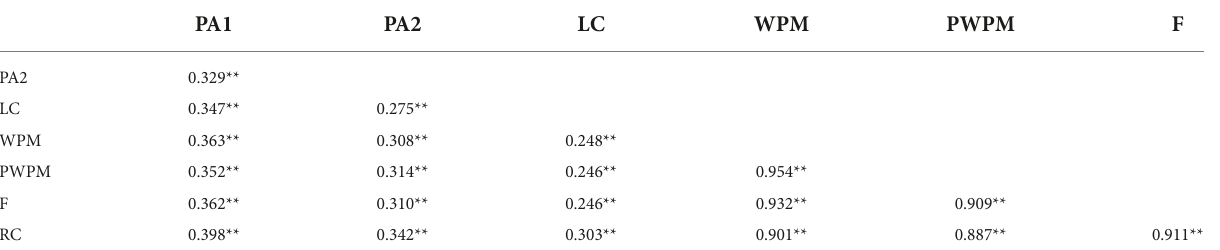
TABLE 1 Pearson’s correlation indices, second grade.